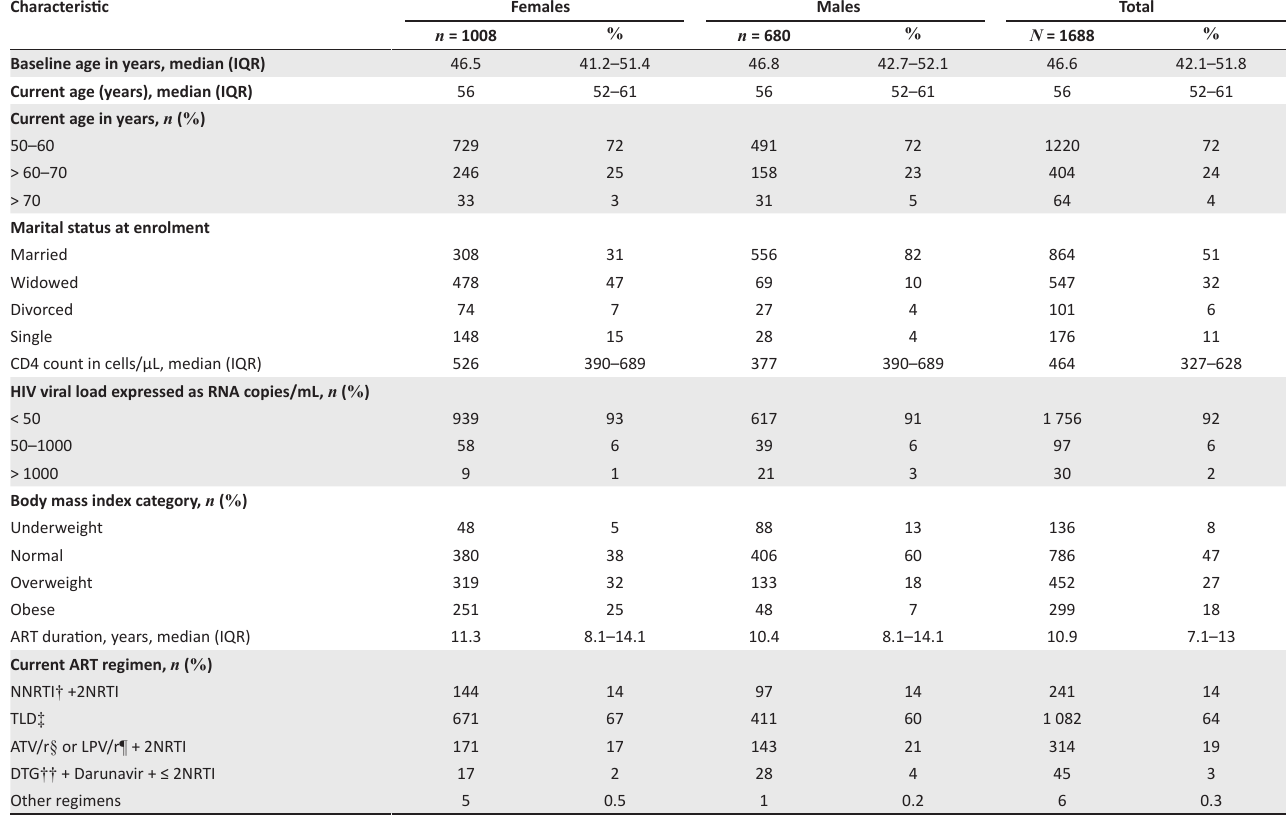
TABLE 1: Demographic and clinical characteristics of elderly patients receiving antiretroviral therapy at Newlands Clinic in March 2020, by sex. Characteristic